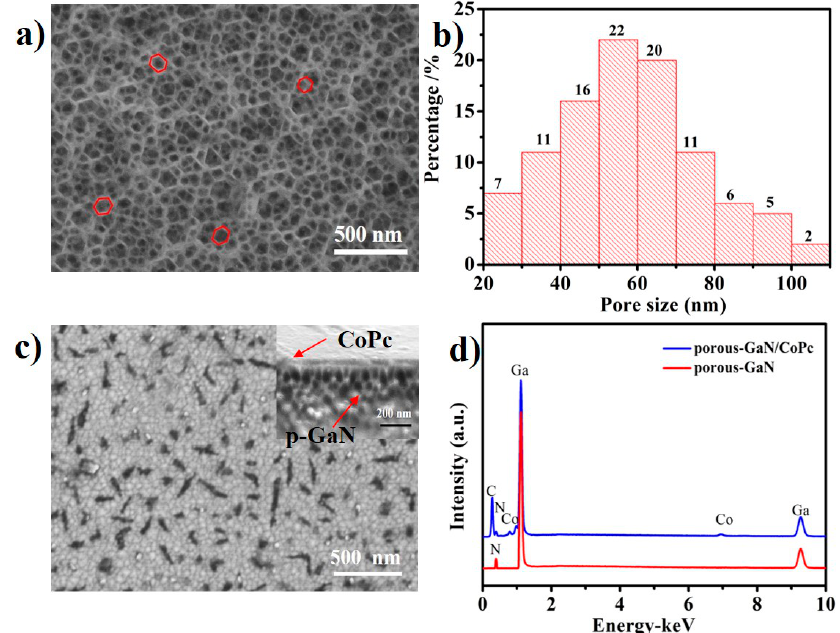
Figure 2. SEM images of ( a ) pure nanoporous GaN and ( b ) the corresponding pore size distribution diagram; ( c ) CoPc / porous-GaN film (inset is the cross section); ( d ) EDX spectra of porous-GaN and CoPc / porous-GaN film.